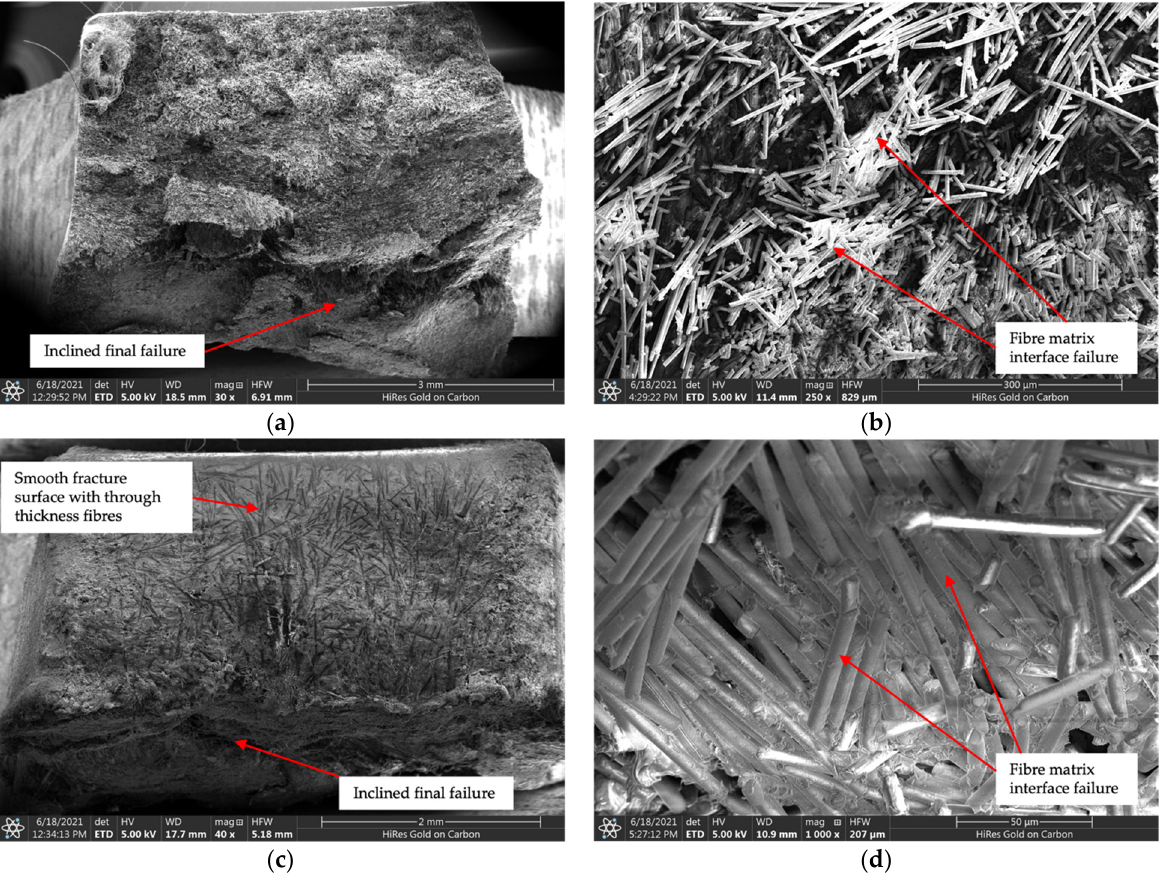
Figure 9. Fatigue fracture surfaces at 120 °C under compression–compression fatigue loading R = 10 ( a ) SCF 𝑁 (cid:3033) = 277,212 ( b ) SCF 𝑁 (cid:3033) = 16,138 ( c ) LCF 𝑁 (cid:3033) = 23,021 ( d ) LCF 𝑁 (cid:3033) = 1,154,468. ( a ) SCF N f = 277,212; ( b ) SCF N f = 16,138; ( c ) LCF N f = 23,021; ( d ) LCF N f =